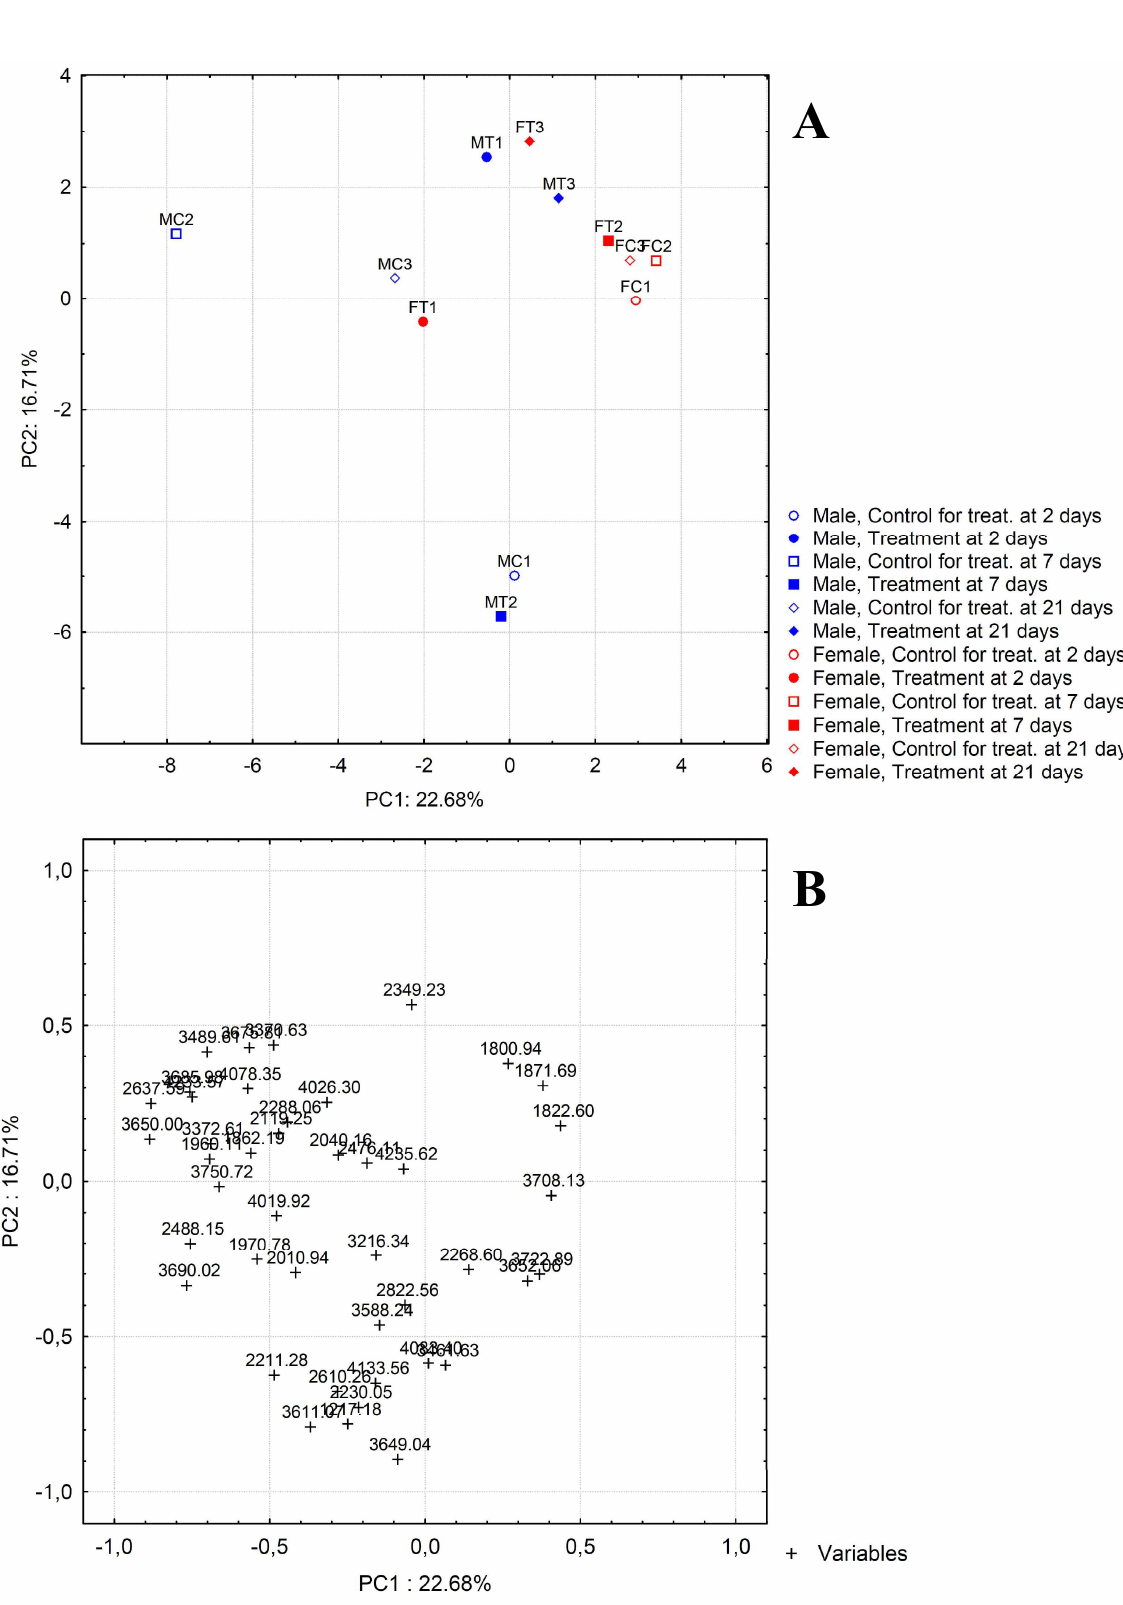
Figure 4. Scores ( A ) and loadings ( B ) plots obtained by Principal Component Analysis applied to mass spectrometry